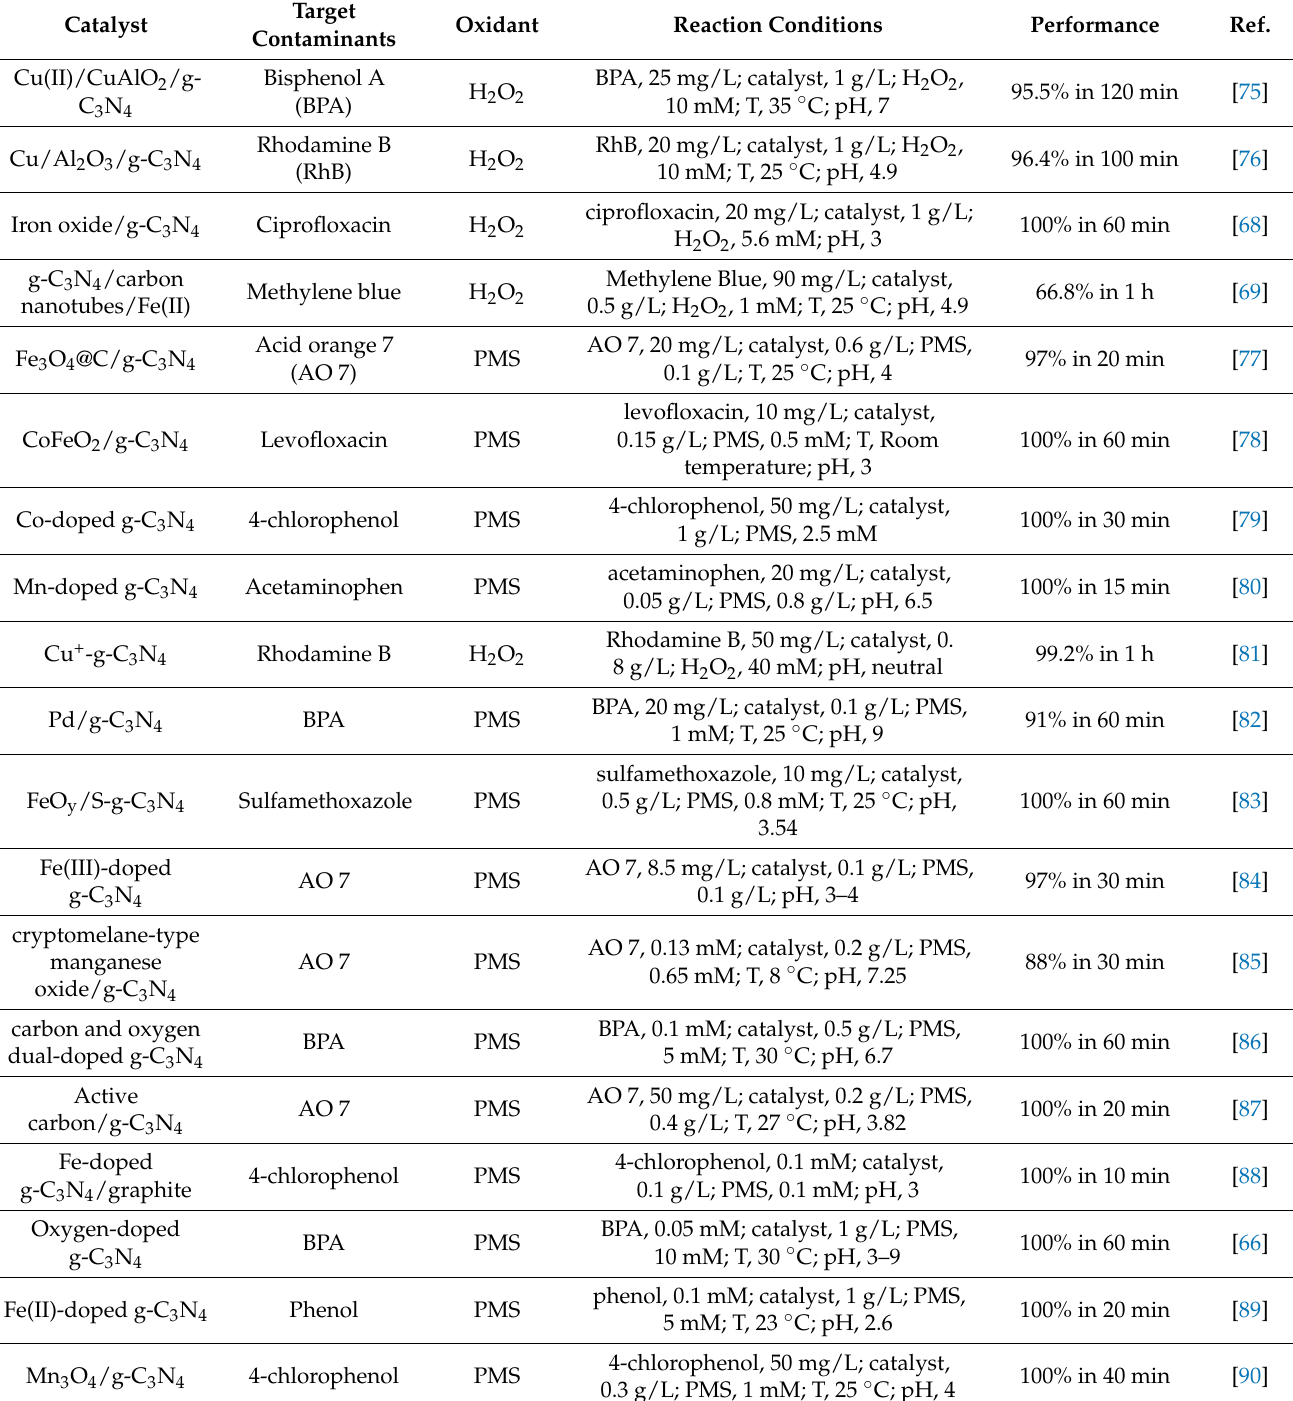
Table 1. Graphic carbon nitride (g-C 3 N 4 ) based composites for chemical advanced oxidation processes